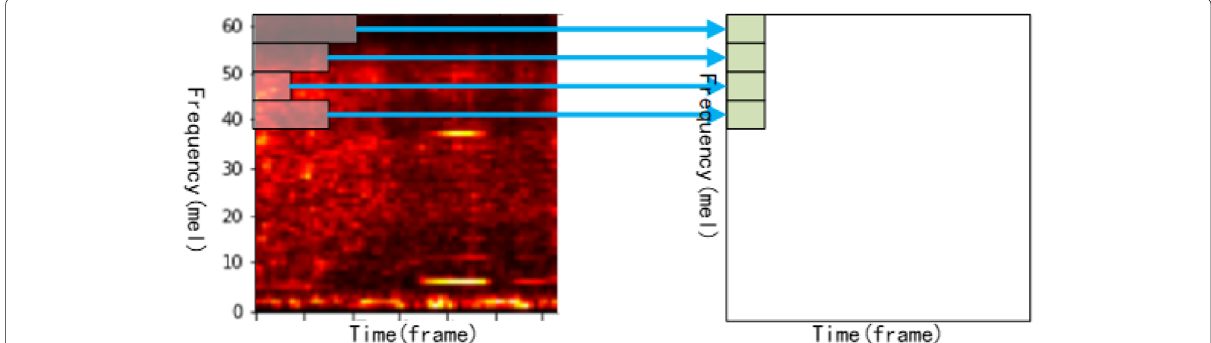
Fig. 4 Model architecture of long-term filter banks. Each row of the spectrogram is convolved by a filter bank with individual width. In this sketch map, time durations of the filter banks in the highest four frequency bins are 3, 2, 1 and 2